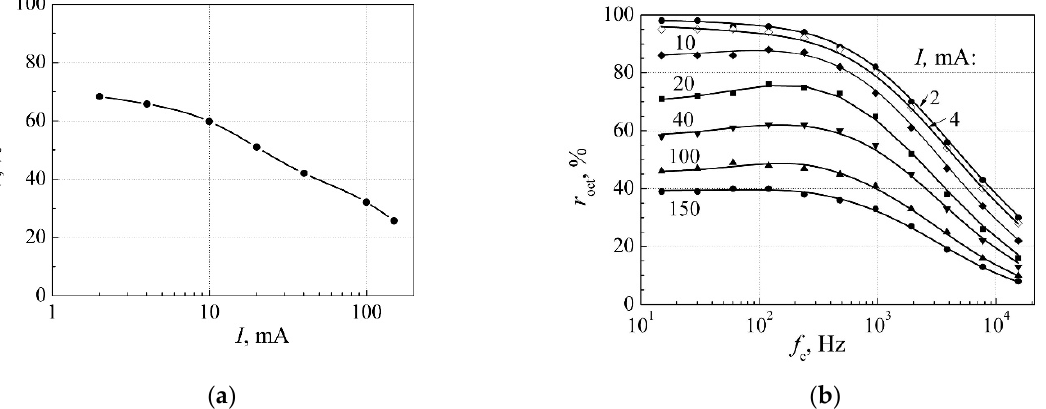
Figure 7. ( a ) Dependence of the cross-correlation coefficient r between electrical and optical fluctuations on current of 3 W white LED in the whole investigated frequency range 10 Hz–20 kHz (dots are the measurement results, solid line is calculated by Equation (12)); ( b ) dependence of the cross-correlation coefficient r oct between electrical and optical fluctuations in the one-octave frequency band on the central frequency f c of the octave filter at different forward currents (dots are the measurement results, solid lines are calculated by Equation (12) for each one-octave filter band). Reprinted with permission from [21].